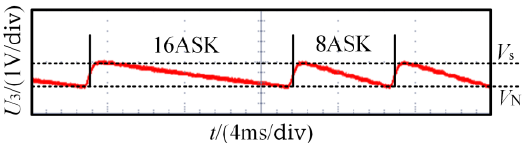
Figure 12. Signal demodulation waveform.